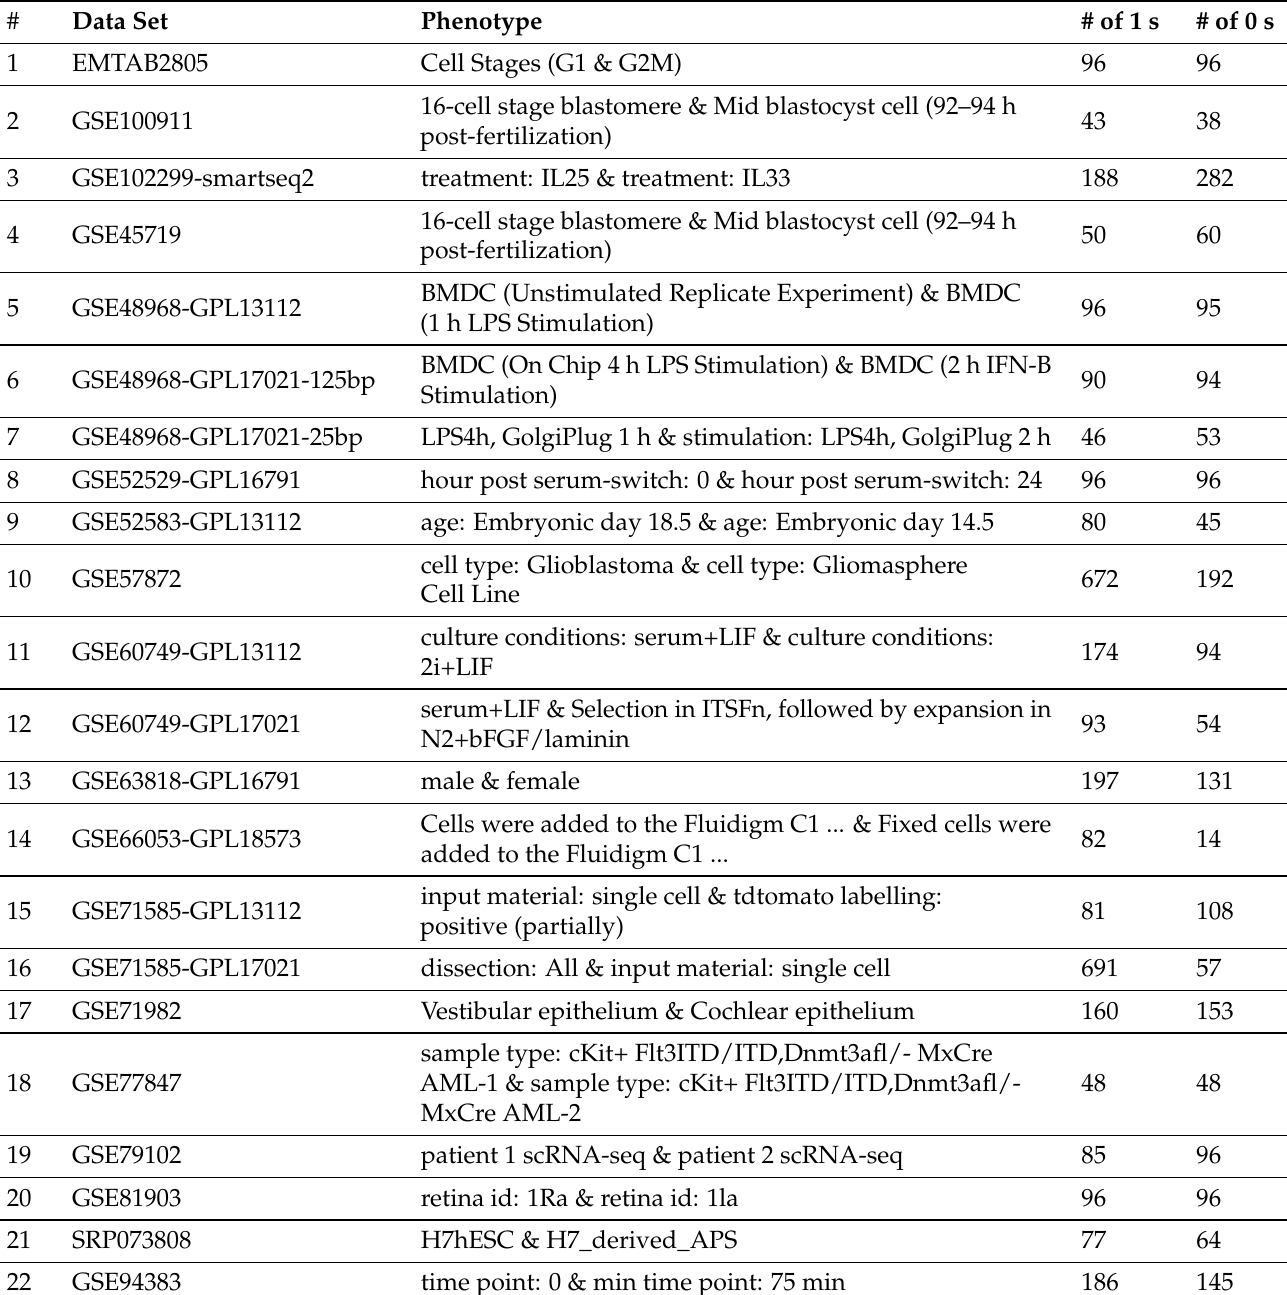
Table 2. List of data sets used in the test along with their associated phenotype that were sat for either 1 or 0. # Data